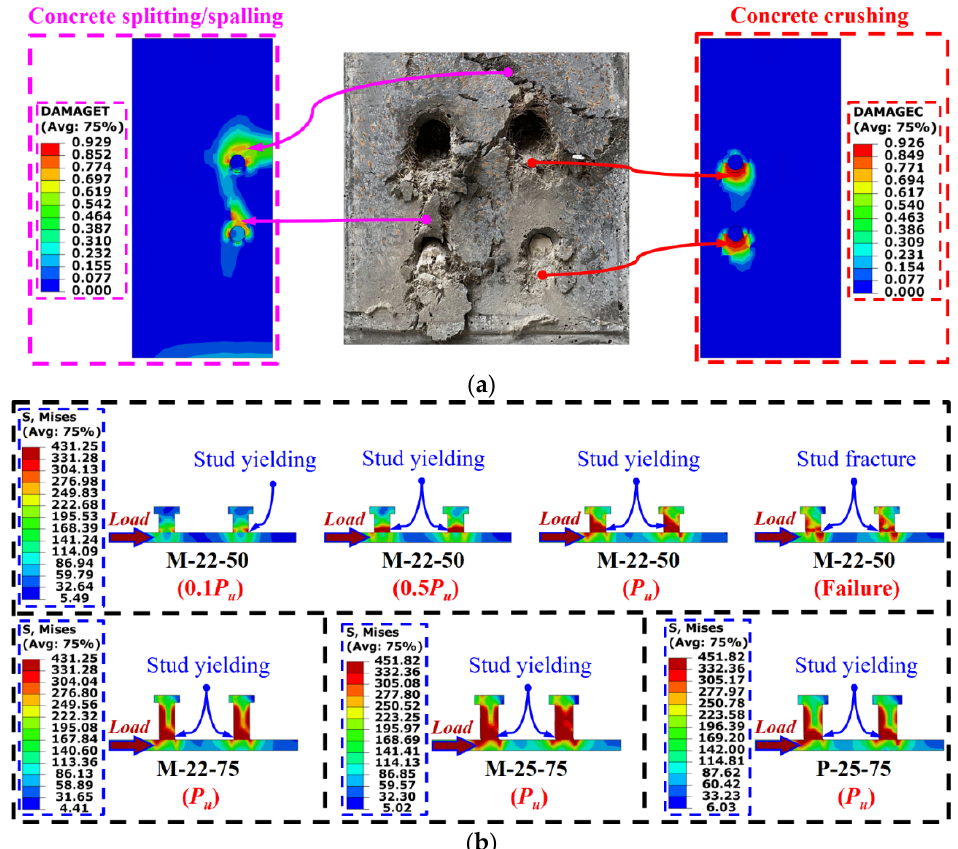
Figure 10. Comparison of failure modes from experimental and FE analysis: ( a ) concrete damage (taking M-22-50 as an example); ( b ) stud Mises stress.